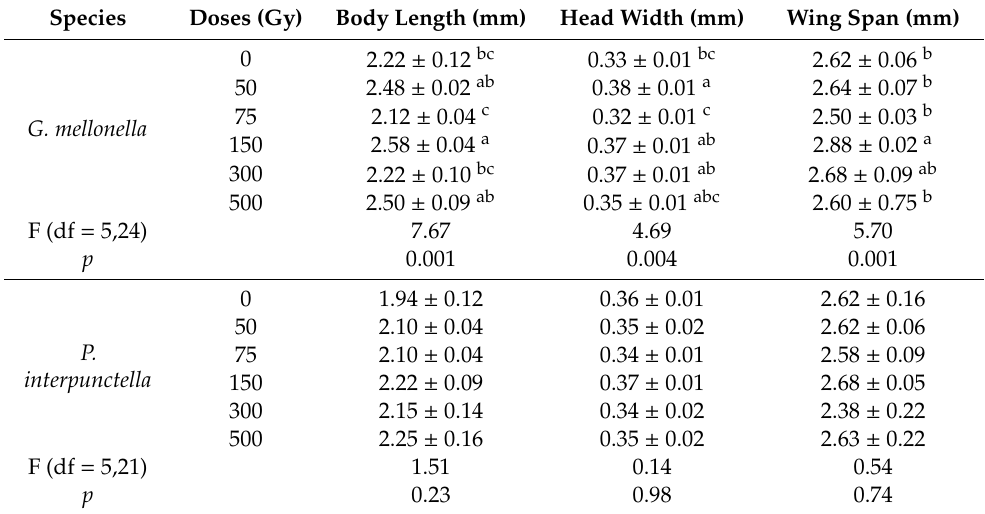
Table 2. Mean ( ± SE) size of female adult parasitoid H. hebetor developing from the irradiated larvae of G. mellonella and P.